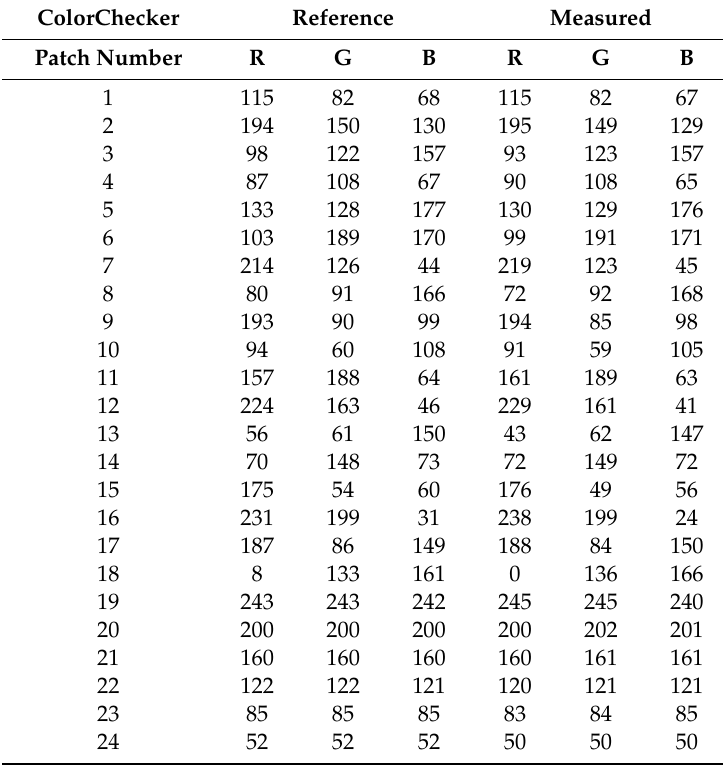
Table 2. Reference RGB values for the ColorChecker patches versus those calculated from the hyperspectral image.